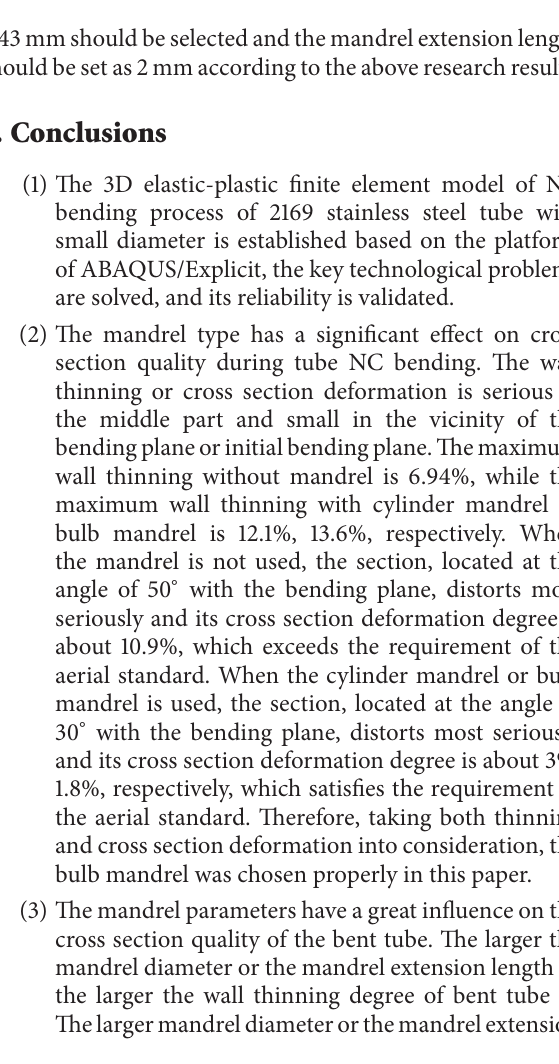
where 𝐷 1 is the inner diameter of the tube; 𝑅 is the centerline bending radius; 𝑑 is the mandrel diameter; and 𝑧 is the clearance between inside wall of tube and